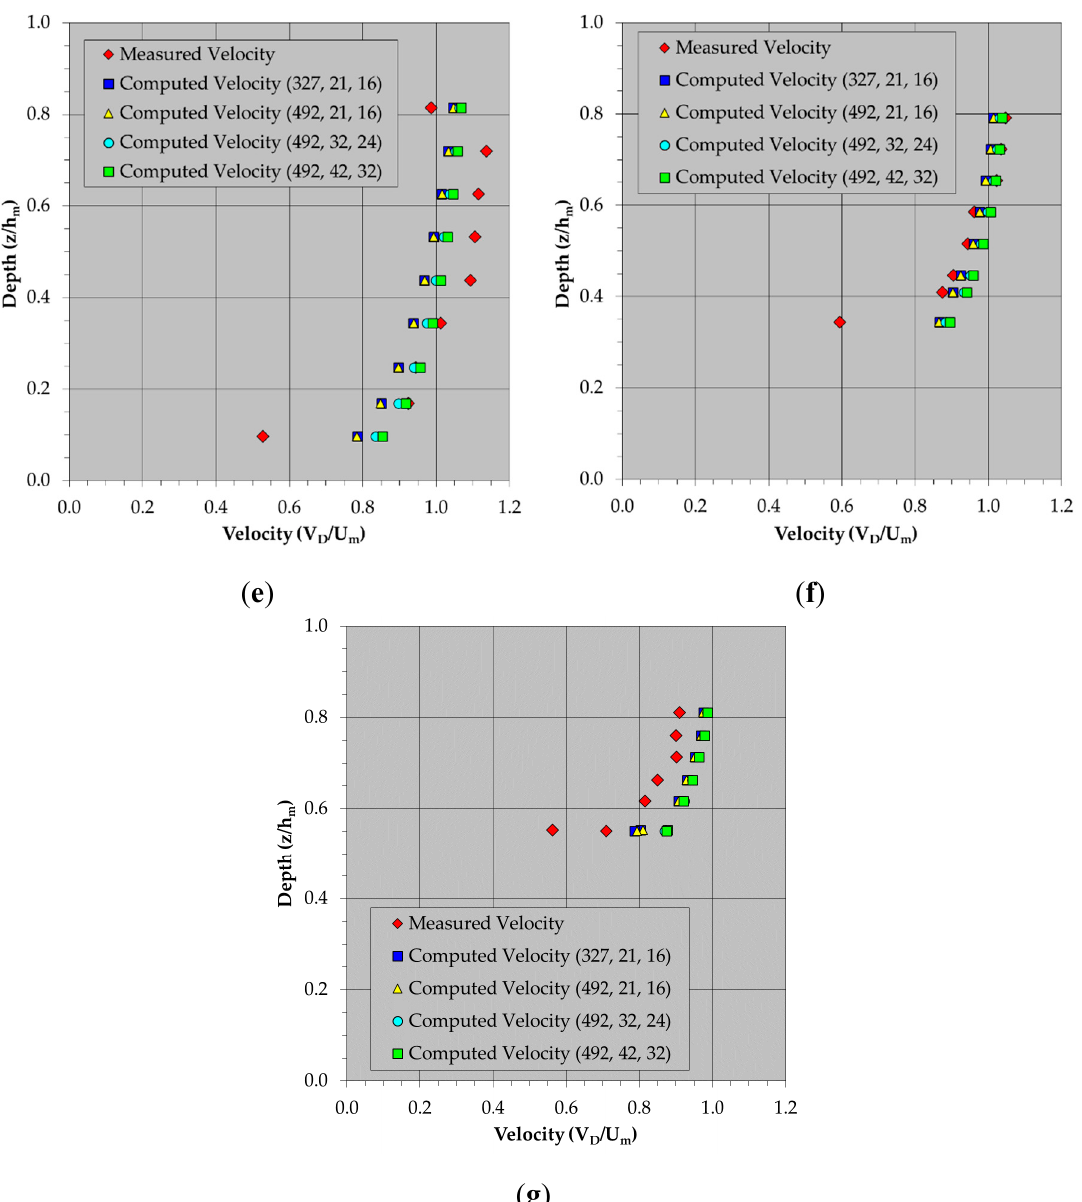
Figure A16. Comparisons of simulated and measured stream-wise velocity profiles using four different mesh sizes at Cross-section 16, located in the downstream channel curve (profile measurement locations “ a ”–“ g ” are positioned left to right looking downstream).